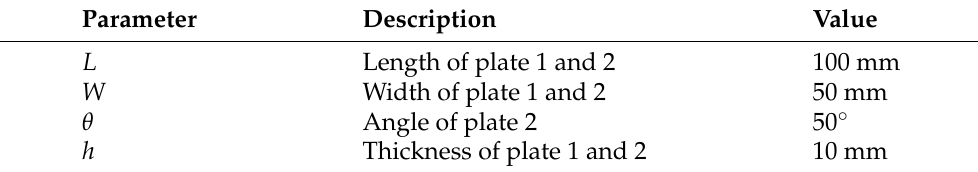
Figure 7. The L-shaped plate investigated in numerical example 1. Table 1. The parameters of the L-shaped plate investigated in numerical example